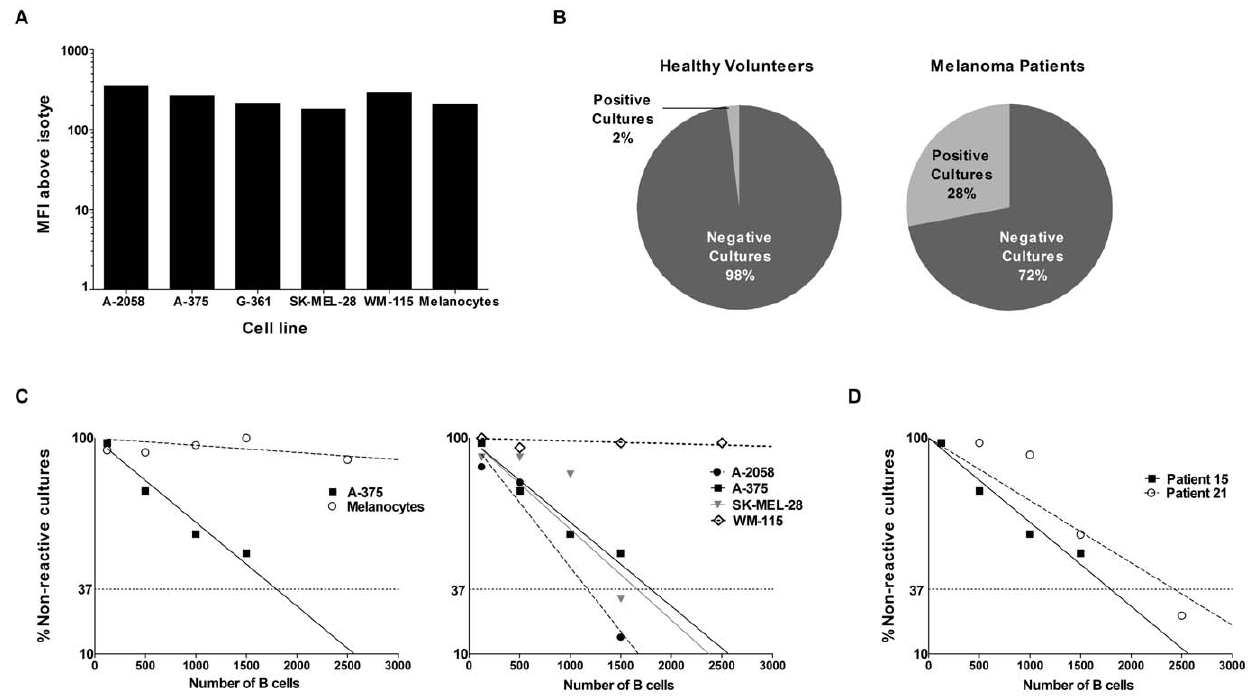
Figure 4. Estimations of the frequency of circulating B cells producing melanoma-reactive antibodies relative to a positive control antibody. (A) Binding of Trastuzumab is consistent across melanoma cell lines and primary human melanocytes evaluated by mean fluorescence intensity (MFI) above isotype control antibody binding for each cell line. (B) Proportion of B cell cultures (n=1,800) from 21 melanoma patients arising from 500 B cells each that produced antibodies that reacted to metastatic melanoma cells compared to cultures (n=600) from 10 healthy volunteers. (C) Frequency of B cells producing IgG antibodies able to bind to melanoma cells estimated by limiting dilution analysis for Patient 15 (see Table 1). The frequency of B cells producing antibodies reactive to the cells of interest was approximated according to Poisson distribution, the number of B cells at which 37% of the cultures were non-reactive (dotted horizontal line). Frequencies of tumor-reactive B cells against A-375 melanoma cells versus melanocytes evaluated at the same B cell densities (left) and against four melanoma cell lines (primary WM-115, and metastatic cell lines derived from different anatomic locations, right). (D) Comparison of the frequency of B cells that react to metastatic melanoma cells between two stage II patients, estimated by limiting dilution analysis. For these two patients, frequency was estimated to be 1 in 1,790 B cells (Patient 15) and 1 in 2,430 B cells (Patient 21).